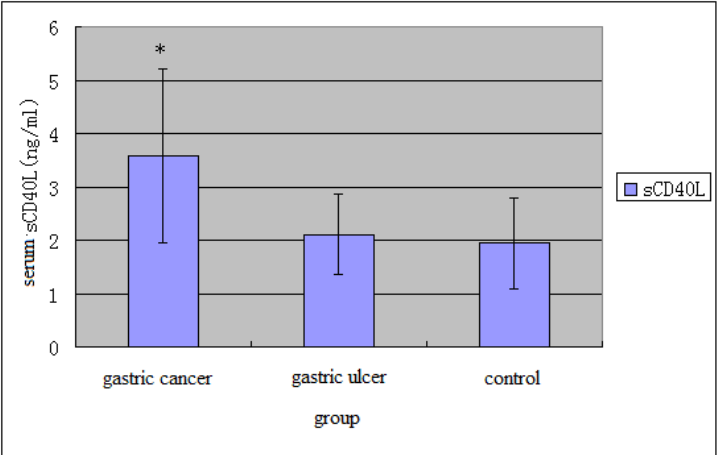
Figure 5. sCD40L levels in three different groups, values are mean ±S.D. *P <